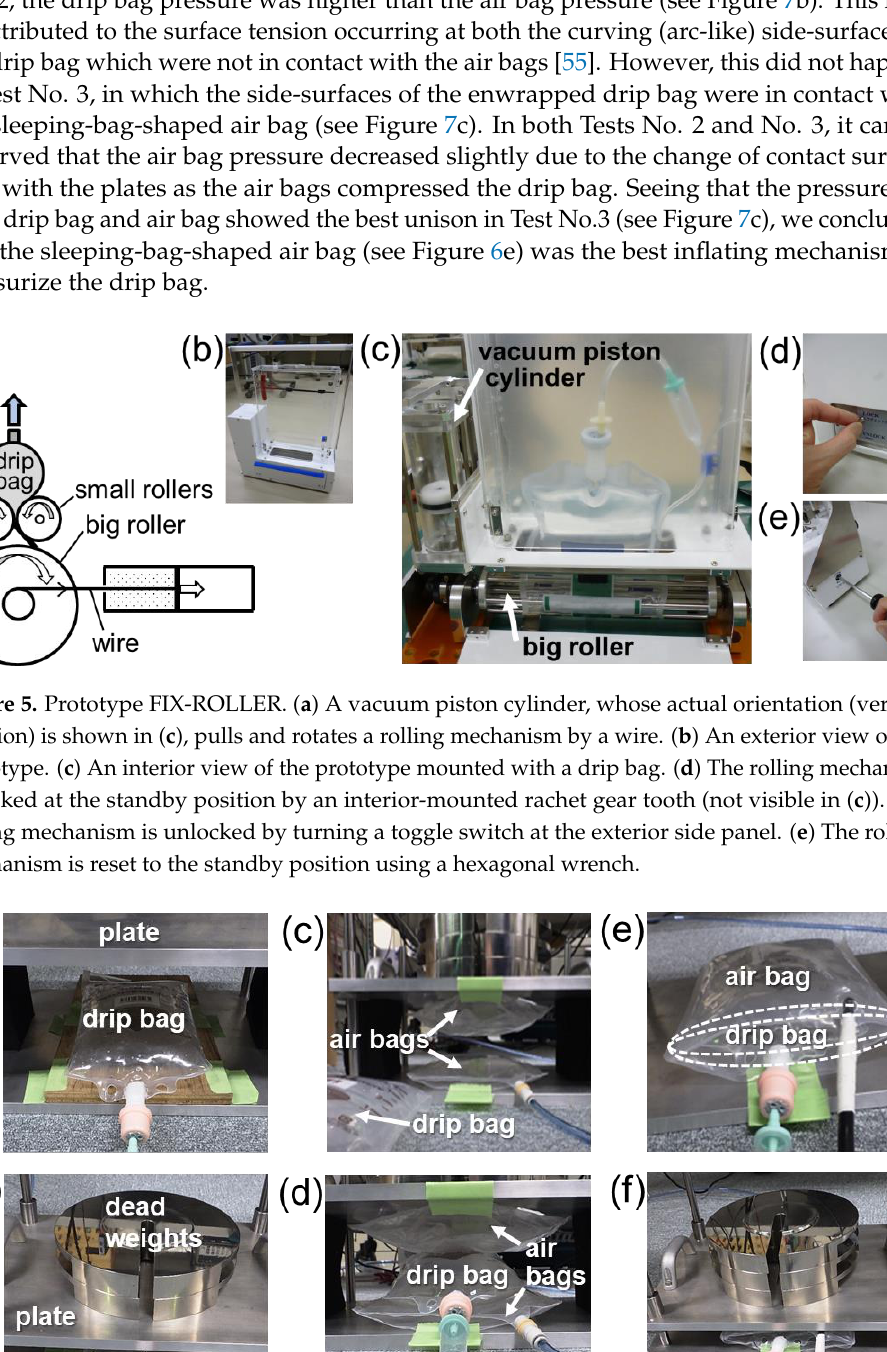
Figure 6. ( a , b ): Test No. 1. A drip bag is placed between parallel plates with no air bag in ( a ), and then loaded with dead weight in ( b ). ( c , d ): Test No. 2. Two pillow-shaped air bags are placed between the parallel plates in ( c ), then a drip bag is inserted in between the two air bags, and the sandwiched drip bag is loaded with dead weight in ( d ). ( e , f ): Test No. 3. A drip bag is enwrapped